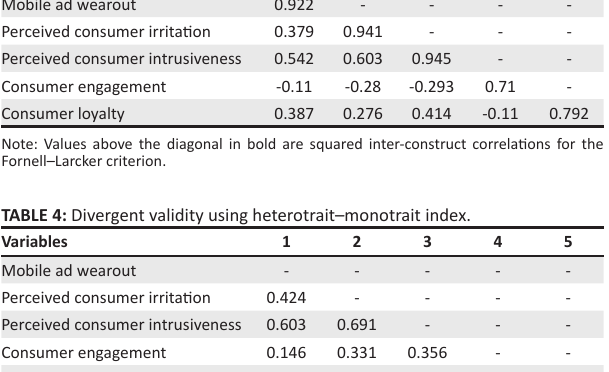
Consumer loyalty